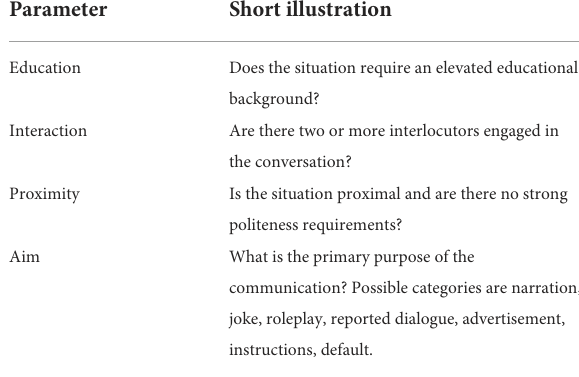
TABLE 3 Project A04: Annotation